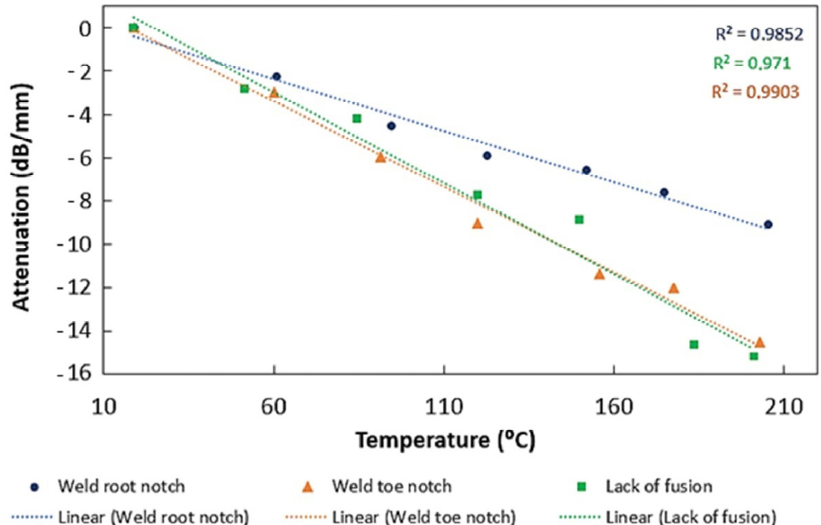
Figure 8. Variation in attenuation with temperature, for different defects.